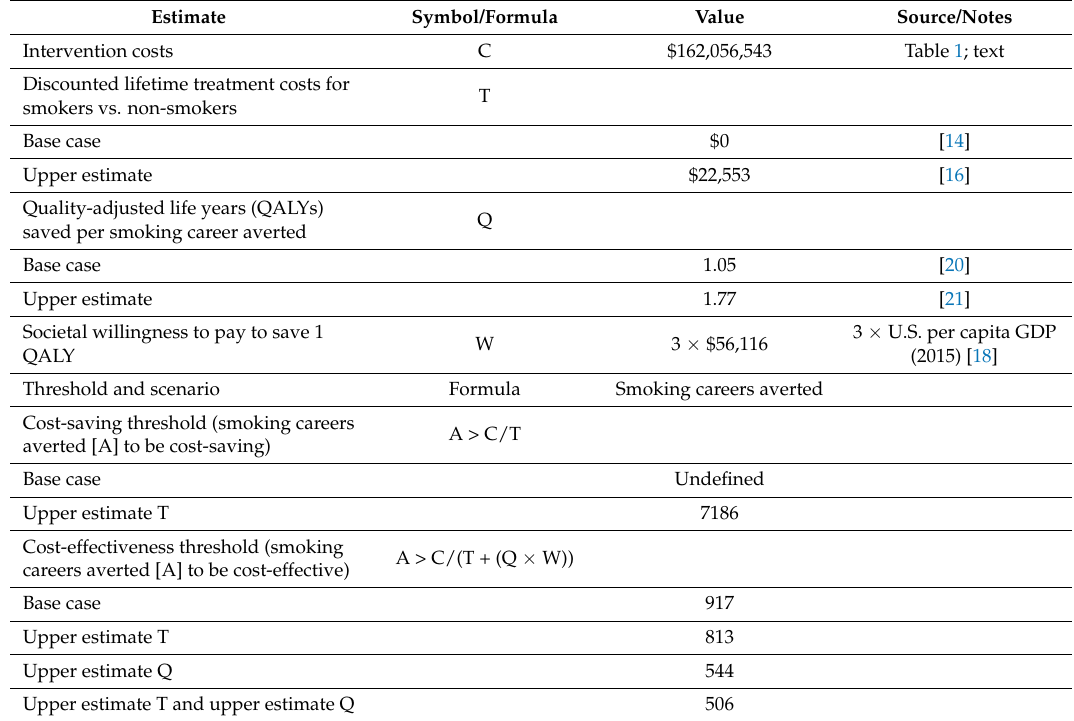
Table 3. Parameter estimates and number of smoking careers averted to reach cost-saving and cost-effectiveness